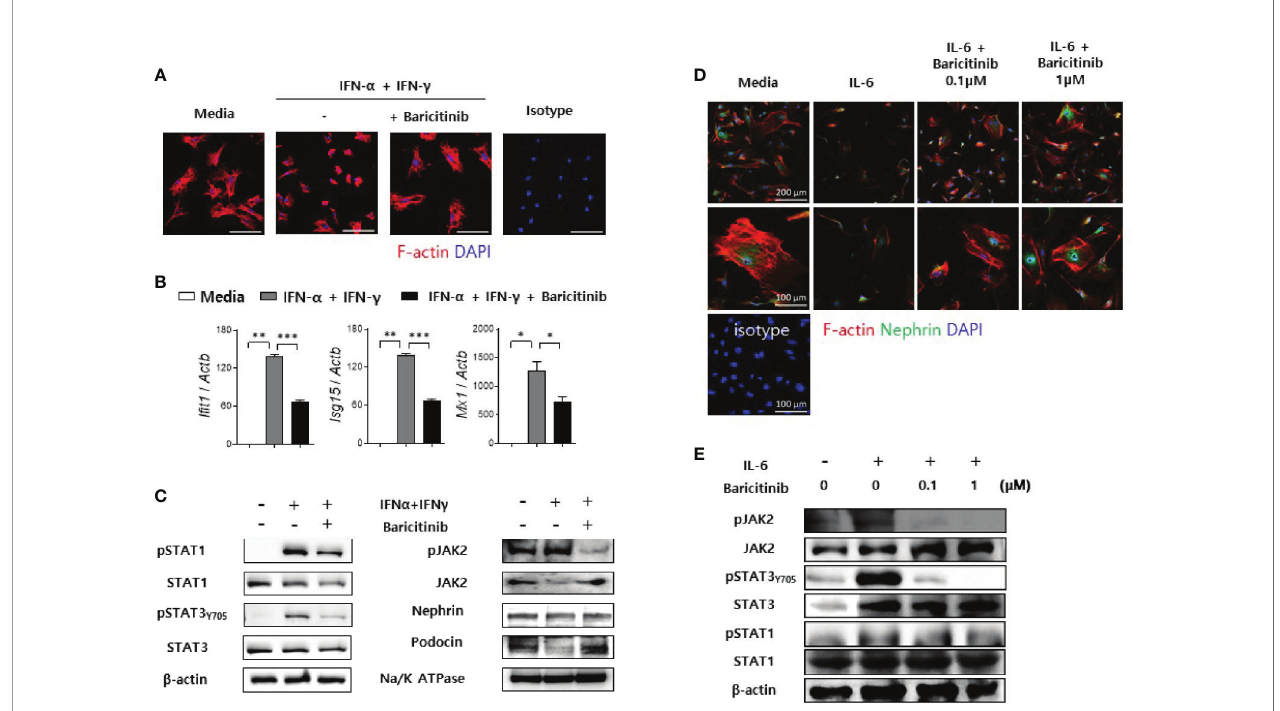
FIGURE 6 | Baricitinib stabilizes podocyte cytoskeleton. (A) After podocyte cell line was differentiated in 37°C permissive condition over 14 days, it was stimulated by 100 U/mL IFN- a and 20 ng/mL IFN- g for 2 days with or without 1 m M baricitinib. Representative confocal microscopic images show actin cytoskeleton of podocytes (phalloidin staining, red). (B, C) Differentiated podocytes were stimulated by the same condition for 4 hours (B) or 30 minutes (C) . mRNA levels of I fi t1 , Isg15 , and Mx1 were determined using real-time PCR (B) . Expression levels of pJAK2, JAK2, pSTAT1, STAT1, pSTAT3 (Tyr705), STAT3, nephrin and podocin were analyzed by western blot (C) . (D, E) Mouse primary podocytes were treated with 10 ng/mL IL-6 for 24 hours (D) or 30 minutes (E) with or without baricitinib. Representative confocal microscopic images of mouse primary podocytes (D) . Cells were stained with DAPI (blue), fl uorescence-conjugated antibodies to nephrin (green) and phalloidin dye (red) to identify F-actin. Expression levels of pJAK2, JAK2, pSTAT3 (Tyr705), STAT3, pSTAT1 and STAT1 were analyzed by western blot (E) . Data are expressed as mean ± SD. * p < 0.05; ** p < 0.01; *** p <